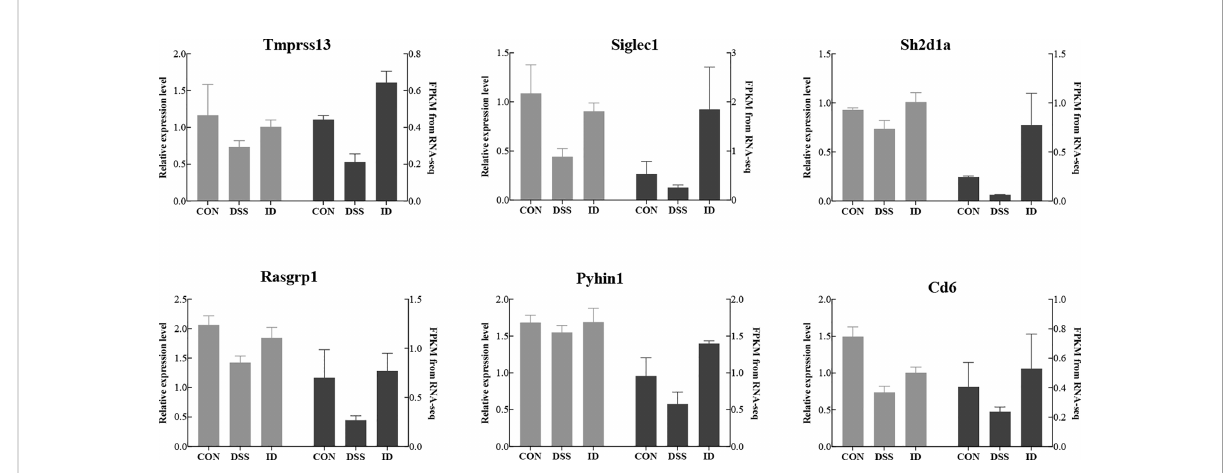
FIGURE 5 Comparison of the gene expression levels of RNA-seq with real-time PCR. The right axis represents the expression levels determined by RNA- seq in FPKM units, and the left axis represents gene expression levels determined by real-time PCR. Bars represent the mean ± SEM of three samples. The black column indicates the FPKM value; the gray column indicates the real-time PCR value using b -actin as a reference gene.